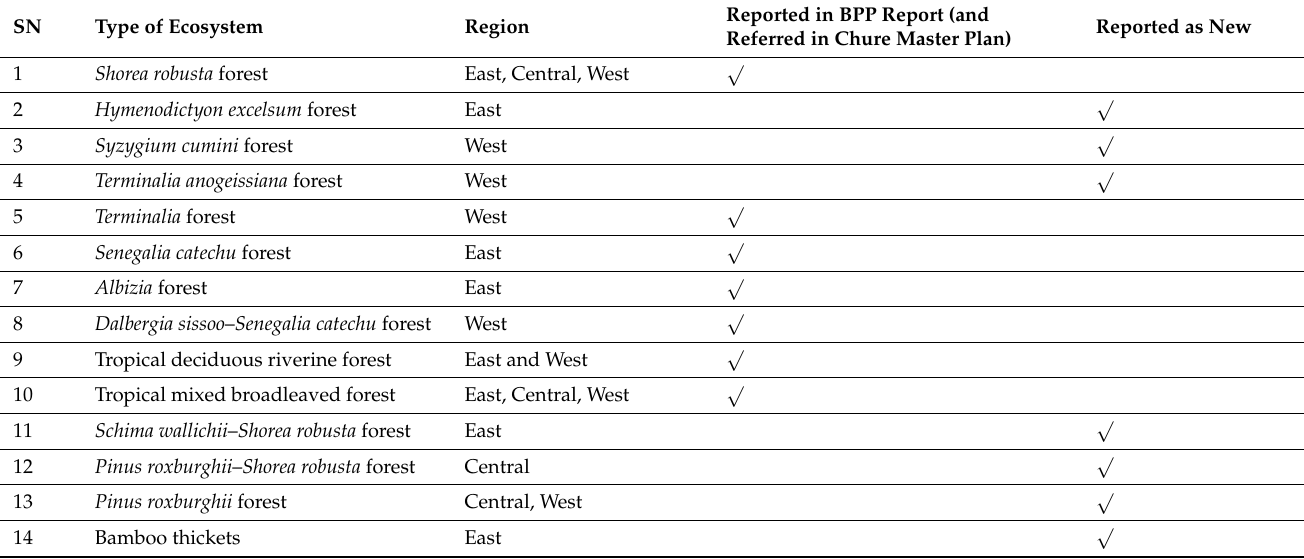
Figure 3. Phtoplates showing some of the forest ecosystem types in Chure. ( A ) Shorea robusta forest ecosystem, ( B ) Syzygium cumini forest ecosystem, ( C ) Terminalia anogeissiana forest ecosystem, ( D ) Terminalia forest ecosystem, ( E ) Senegalia catechu forest ecosystem, ( F ) Dalbergia sissoo–Senegalia catechu forest ecosystem, ( G ) Tropical deciduous riverine forest ecosystem, ( H ) Tropical mixed broadleaved forest ecosystem, ( I ) Schima wallichii–Shorea robusta forest ecosystem, ( J ) Pinus roxburghii – Shorea robusta forest ecosystem, ( K ) Pinus roxburghii forest ecosystem, ( L ) Bamboo thickets. Table 2. Forest ecosystems in